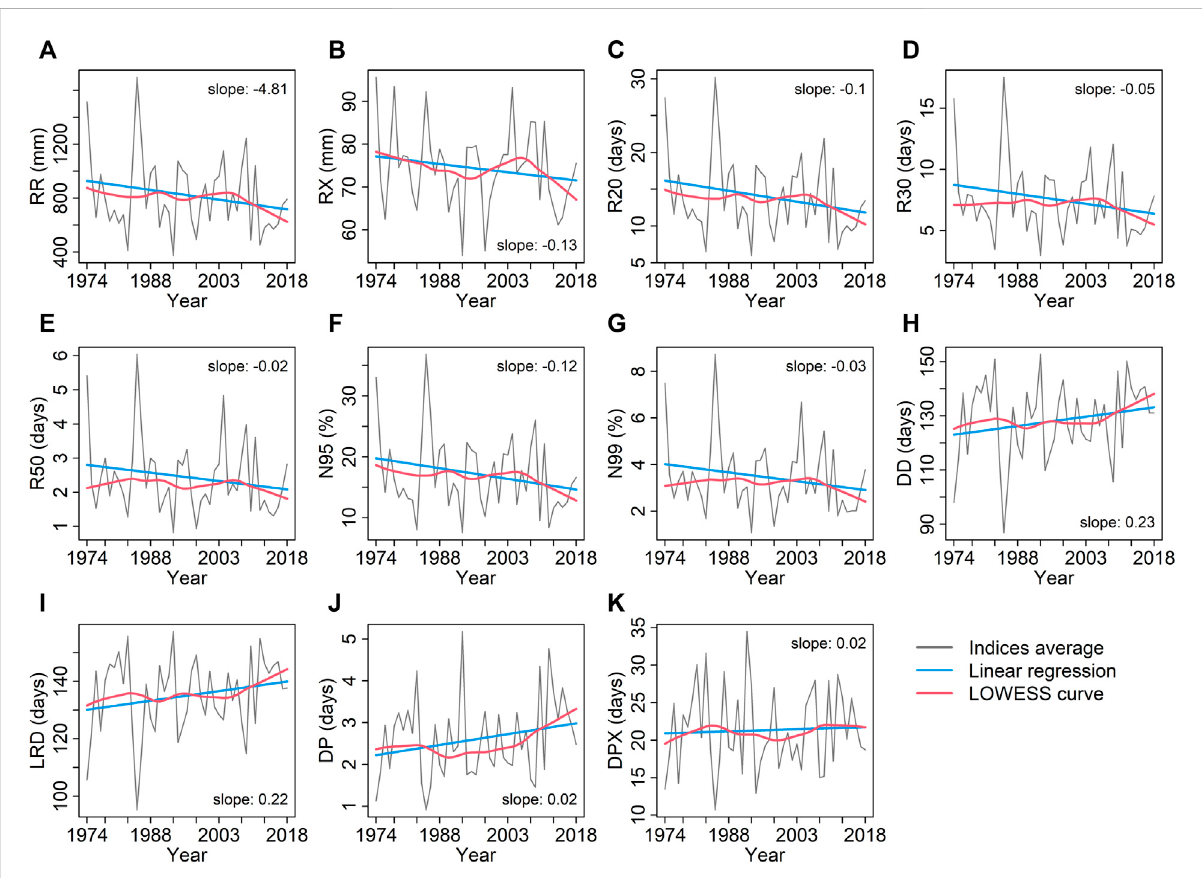
FIGURE 5 LOWESS curve (red line) and linear regression (blue line) related to (A) RR, (B) RX, (C) R20, (D) R30, (E) R50, (F) N95, (G) N99, (H) DD, (I) LRD, (J) DPand (K) DPXoftargetstationsduringtherainyseasonfrom1974to2018.Thenumberreferstoaslopeoflinearregression.The*symbolindicates the slope was signi fi cant at the 5%